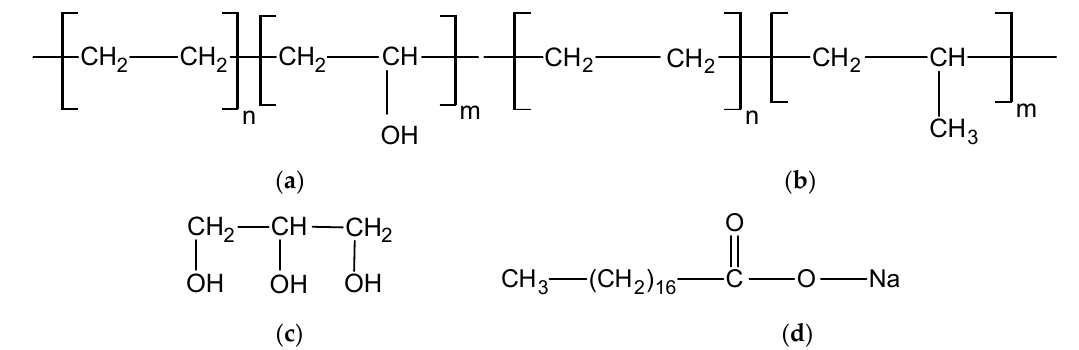
Figure 1. The structure of components: ( a ) EVOH, ( b ) EPC, ( c ) glycerol, ( d ) sodium stearate.